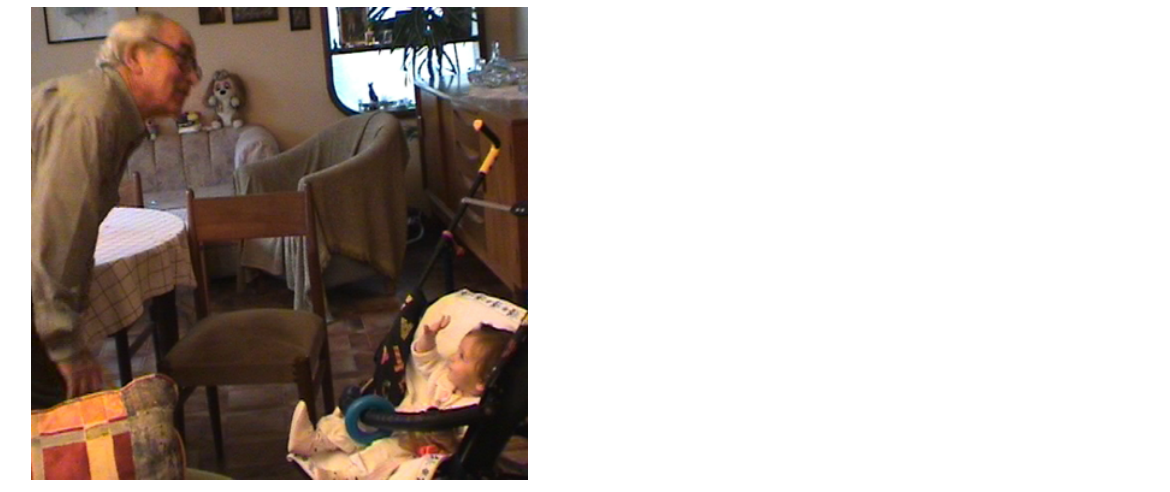
Figure 1.3. The infant grandchild is raising her right hand higher and stretching her fingers while smiling and looking at her